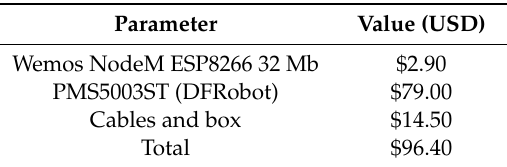
Table 3. AirPlus system